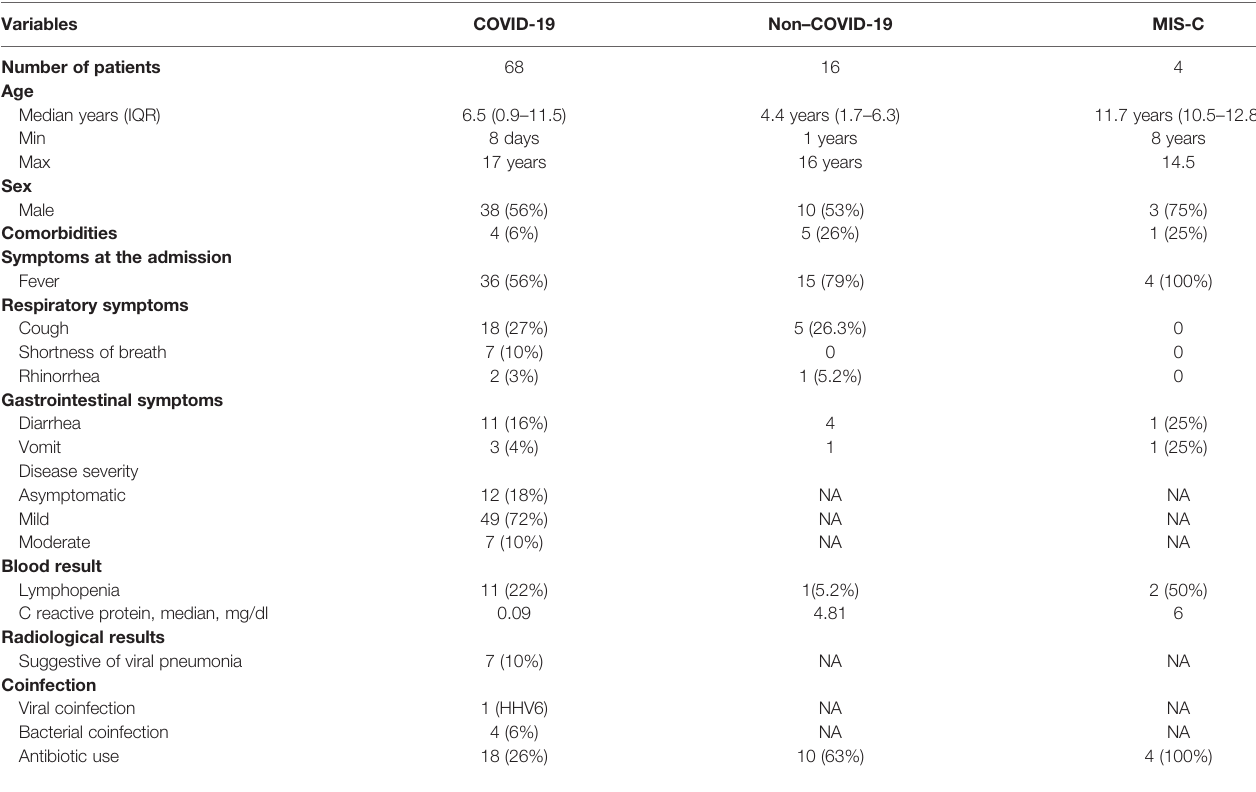
TABLE 1 | Demographic and clinical features at the